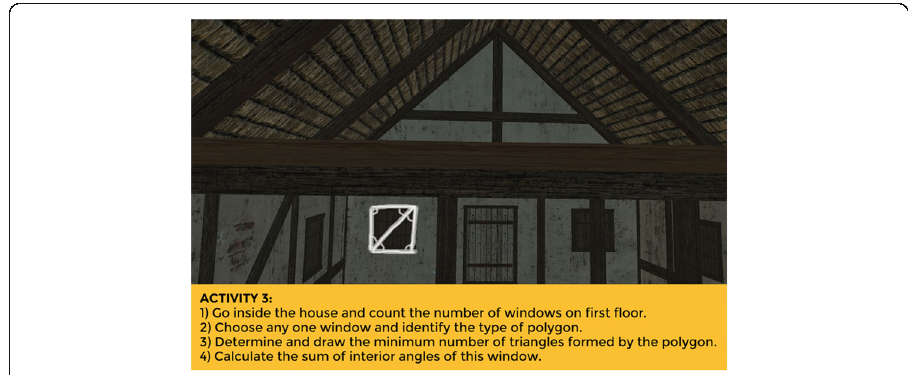
Fig. 2 Activity 3 - Interior and Exterior Angles of a Triangle in the Lines and Angles module of